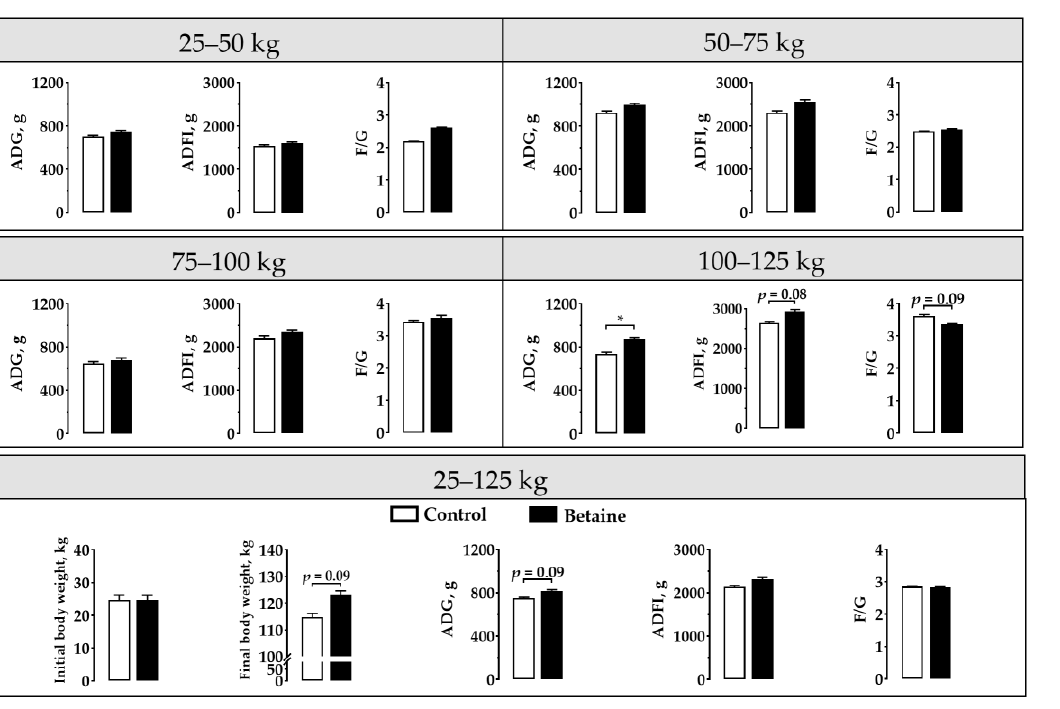
Figure 1. Effects of betaine on growth performance in growing-finishing pigs. ADG, average daily gain; ADFI, average daily feed intake; F/G, the feed intake to gain ratio. * p < 0.05 versus the control group.